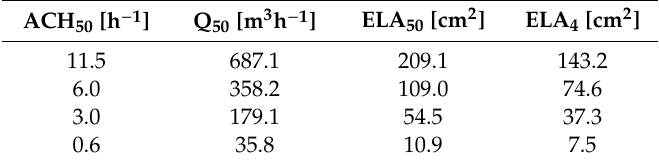
Table 9. Airflow data transformation and conversion for the four airtightness levels.